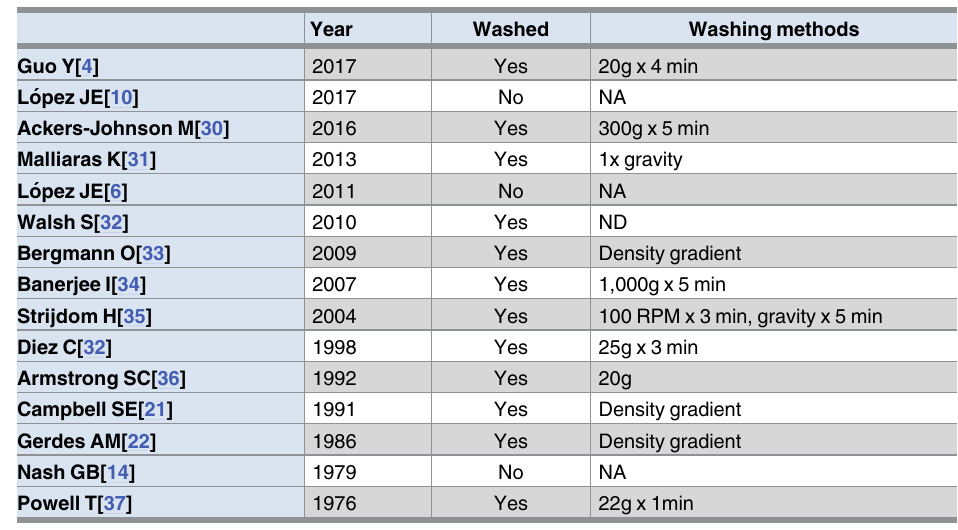
Data reproducibility in adult ventricular myocyte flow cytometry We found no significant difference in accuracy (Figs 1B and 2A) and precision (Fig 2B) when comparing the VM size of not-filtered sample to samples filtered with a 200μm mesh. This finding is true for VMs that range from volumes as low as 7,562μm 3 (young heart) to as high as 48,595μm 3 (HT#2 heart, Fig 1). We, however, did notice clogging of the Coulter Multisizer with not-filtered samples which prompted the need to eliminate the replicate runs with clog- ging. We had no clogging with samples filtered through a 200μm mesh and utilize this as the standard for further experiments. Table 2. Ventricular myocyte isolations and cell